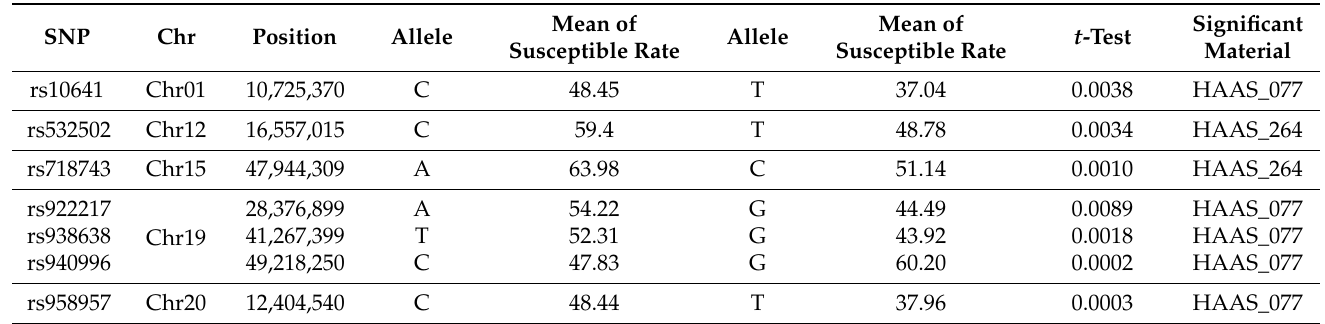
Table 6. Favorable allele effects and carrier